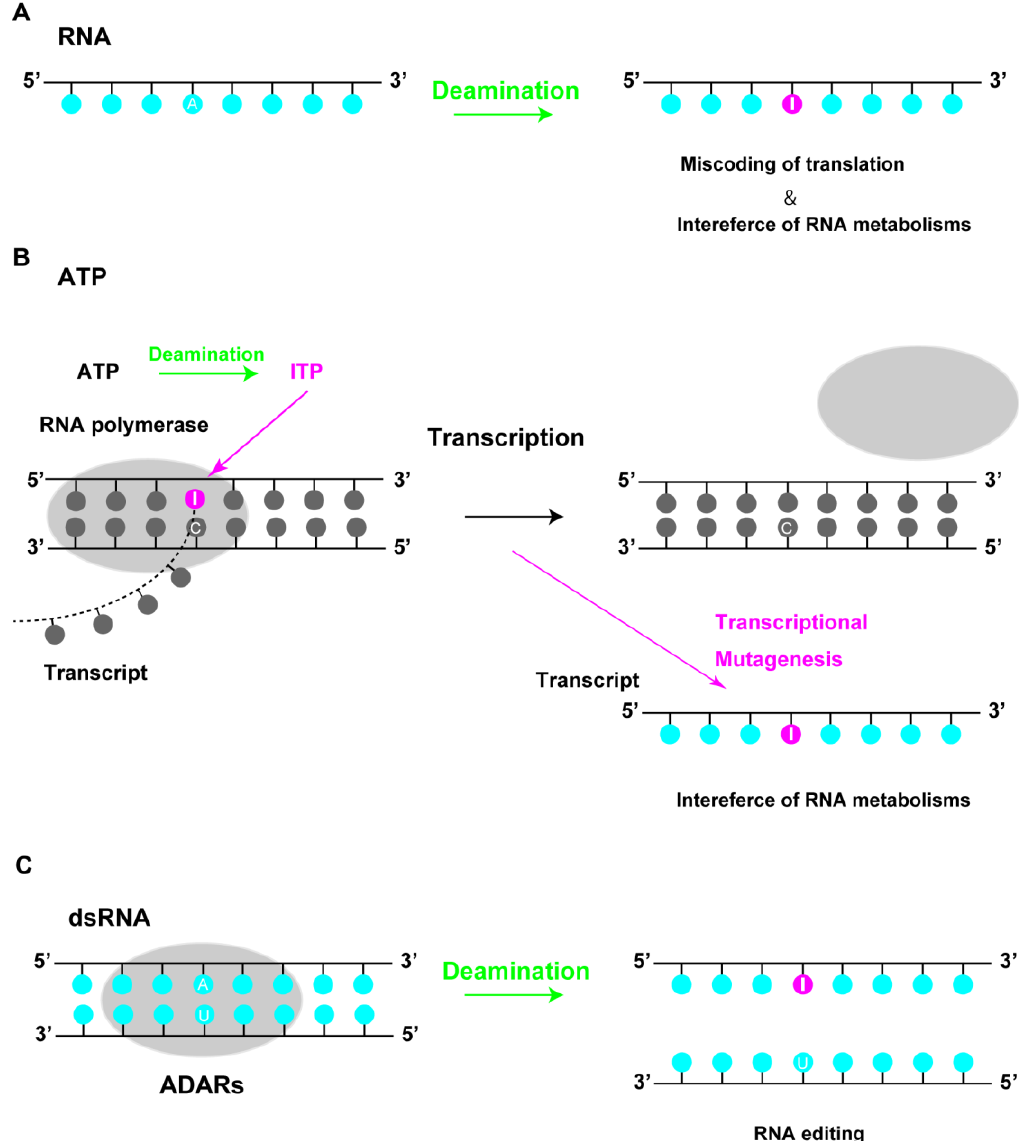
Figure 4. Inosine in RNA. ( A ) Inosine is produced by deamination in RNA. As inosine is recognized as guanine during translation, this deamination leads to miscoding of transcription or interference of RNA metabolism; ( B ) Deamination of ATP produces ITP, which accumulates in the nucleotide pool and is inserted into the transcript by RNA polymerase during transcription elongation. Transcriptional mutagenesis results in miscoding of proteins or interference of RNA metabolism; ( C ) Conversion of adenosine (A) residues to inosine (I) within dsRNA is catalyzed by adenosine deaminases acting on RNA (ADARs). They catalyze RNA editing at specific sites in the dsRNA structure, suggesting that their proper functioning may be crucial to RNA